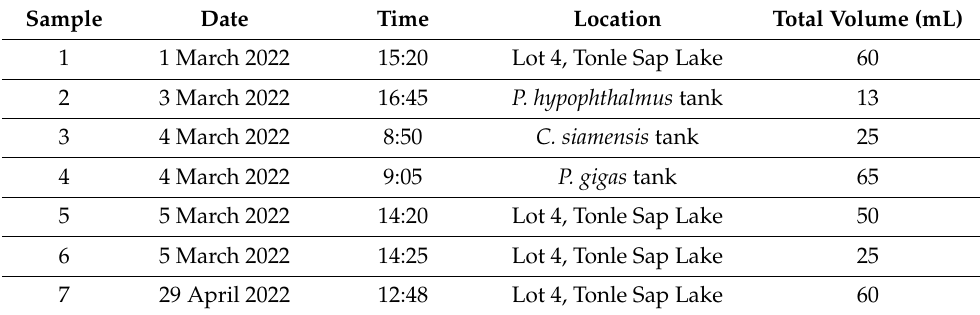
Table 1. The time, location, and volume of water filtered for each of the eDNA samples.